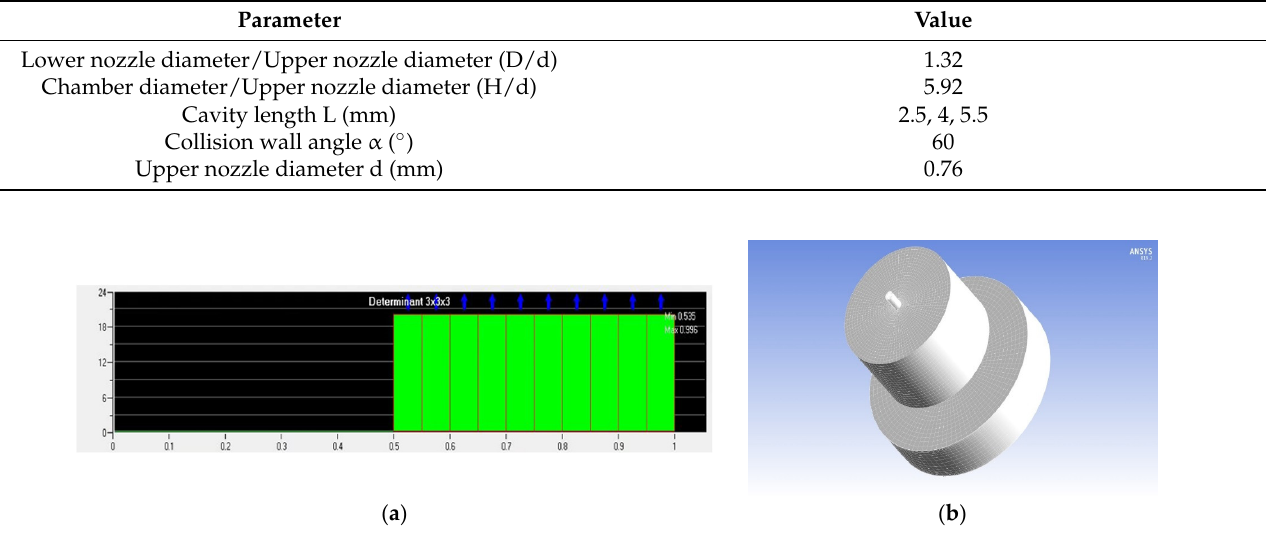
Figure 2. Three-dimensional grid sketch and grid quality diagram. Grid quality diagram ( a ). Three-dimensional grid sketch ( b ).